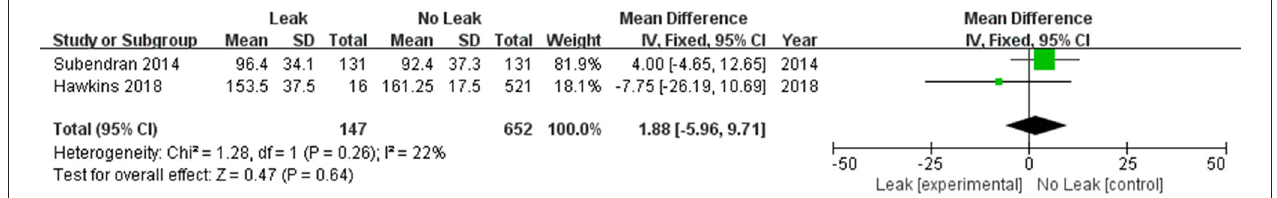
FIGURE 7 | The relation between total dose of ketorolac use and anastomotic leak